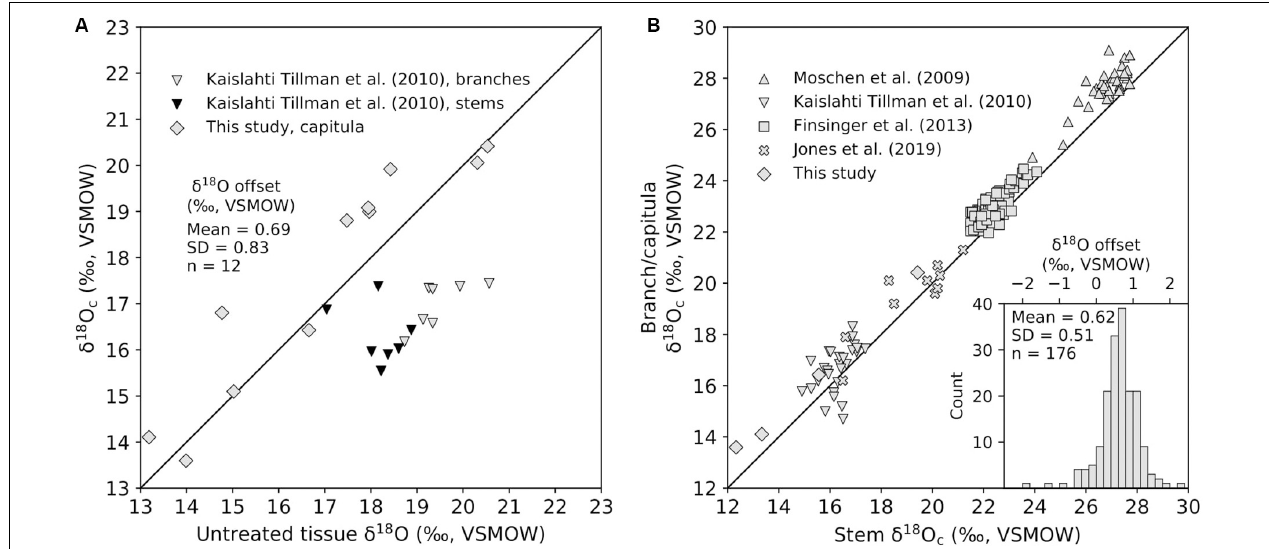
FIGURE 2 | Oxygen isotope offset between different Sphagnum materials. (A) Biplot showing the relationship between δ 18 O c and untreated bulk tissue δ 18 O. Data reported from Kaislahti Tillman et al. (2010) were derived from subfossil Sphagnum branches or stems in peat and are plotted below the 1:1 line, indicating that δ 18 O c are lower than untreated bulk tissue δ 18 O in peat. Data from this study were derived from fresh capitula material and are plotted mostly above the 1:1 line, indicating that δ 18 O c are higher than untreated fresh capitula δ 18 O. (B) Biplot showing the relationship between branch/capitula δ 18 O c and corresponding stem δ 18 O c . Data reported from Moschen et al. (2009), Kaislahti Tillman et al. (2010), and Finsinger et al. (2013) were derived from subfossil Sphagnum branches or stems in peat, while data from Jones et al. (2019) and this study were derived from fresh plants. The results tend to show that branch or capitula δ 18 O c are higher than stem δ 18 O c and the offset (branch/capitula δ 18 O c minus stem δ 18 O c ) resembles a Gaussian distribution as shown in the inset histogram.